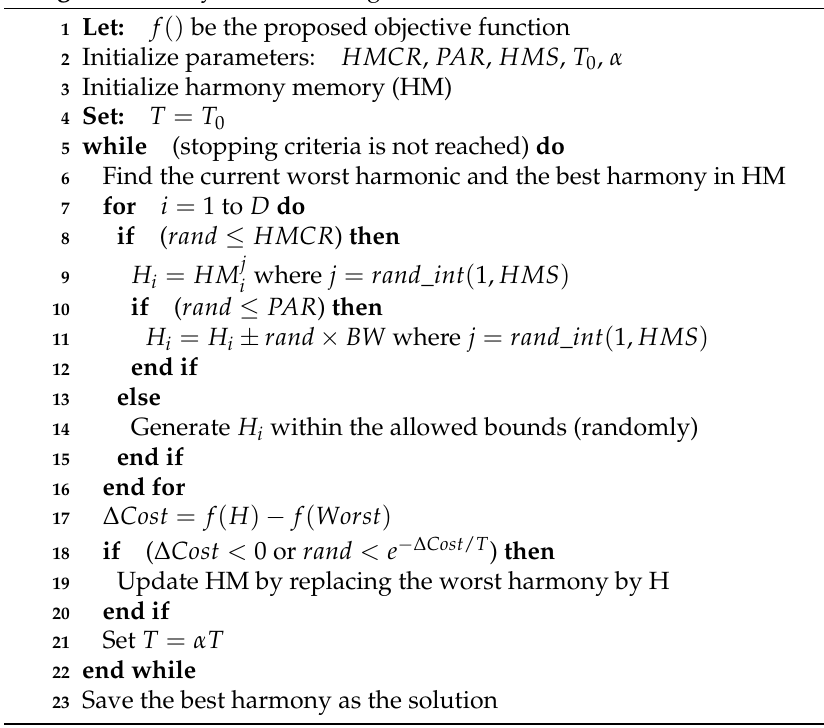
Algorithm 1: Hybrid HS-SA